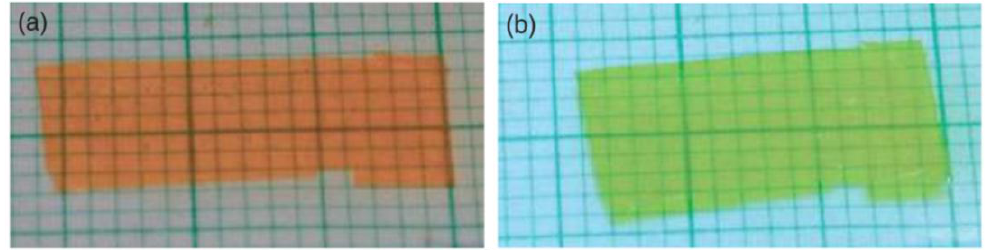
Figure 6. Contraction in a monodomain side-on nematic azo LCE film between ( a ) initial state (before irradiation); and ( b ) under UV irradiation (background in graduated paper). Reprinted with permission from Reference [65], Copyright 2003, Wiley ACH, Advanced Materials .